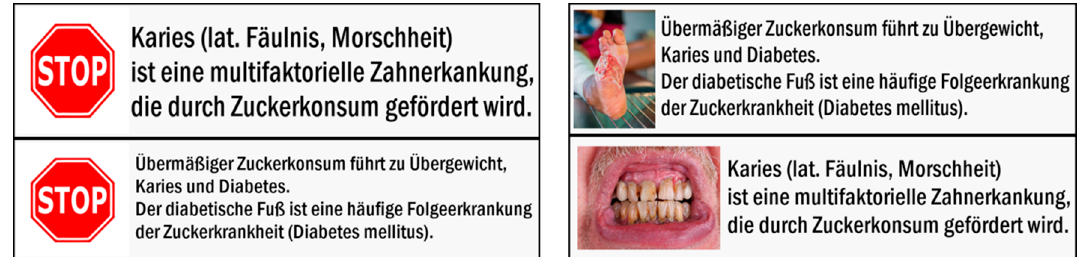
Figure 1. Four different health warning messages were created. For the “Stop” examination condition, a stop sign was used (two pictures on the left). For the “Shock” examination condition, two shocking pictures (one of a denture affected by caries and one of a foot with diabetic foot syndrome) were used. The textual information informed about caries and the diabetic foot syndrome and was identical for both types of warning messages.